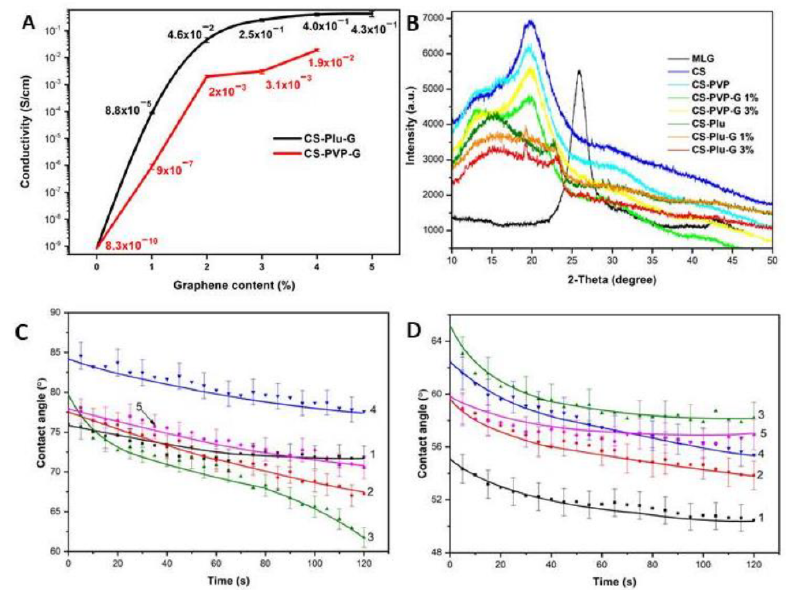
Figure 5. ( A ) Electrical conductivity of CS-PVP/Plu composite films containing exfoliated graphene. ( B ) XRD investigations did not reveal the patterns of MLG, indicating high degree of exfoliation of graphene. The static contact angle measurements of CS (1), CS-Plu-G 1% (2), CS-Plu-G 3% (3), CS-PVP-G 1% (4) and CS-PVP-G 3% (5) films in distilled water ( C ) and ethylene glycol ( D ). At the 3% concentration of graphene, the electrical conductivity reached a plateau. In